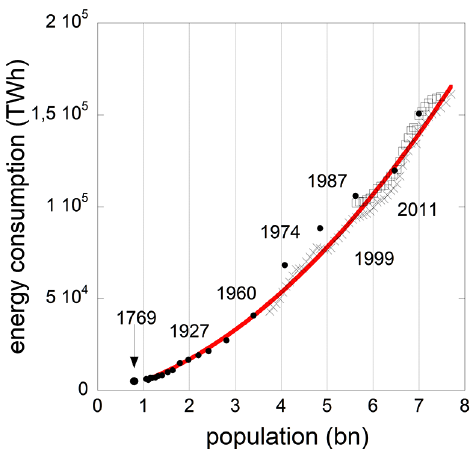
Fig. 2. – Global energy consumption growth vs. the population growth starting in 1769 when James Watt’s patent was accepted. Data are collected from various internet sources. The red line is a parabolic fit.